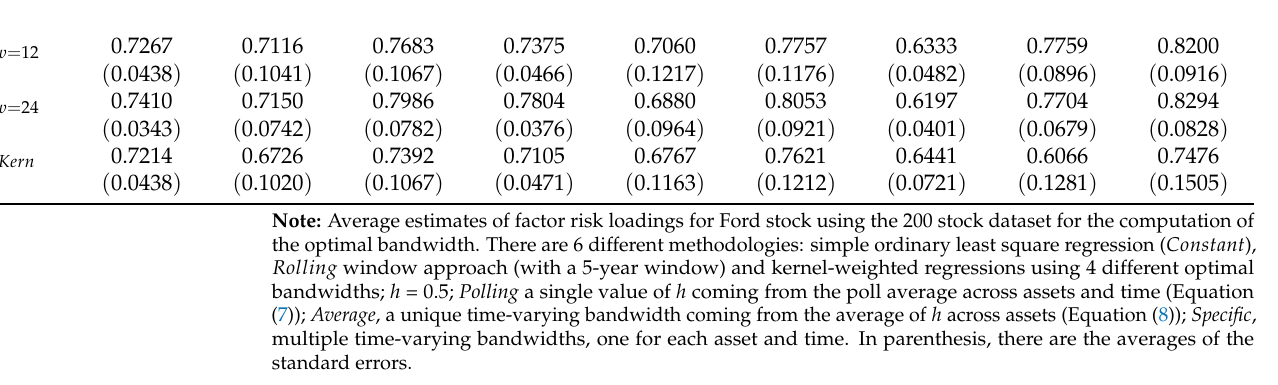
Table 3. Factor risk loading estimates for ME3.BM3—25